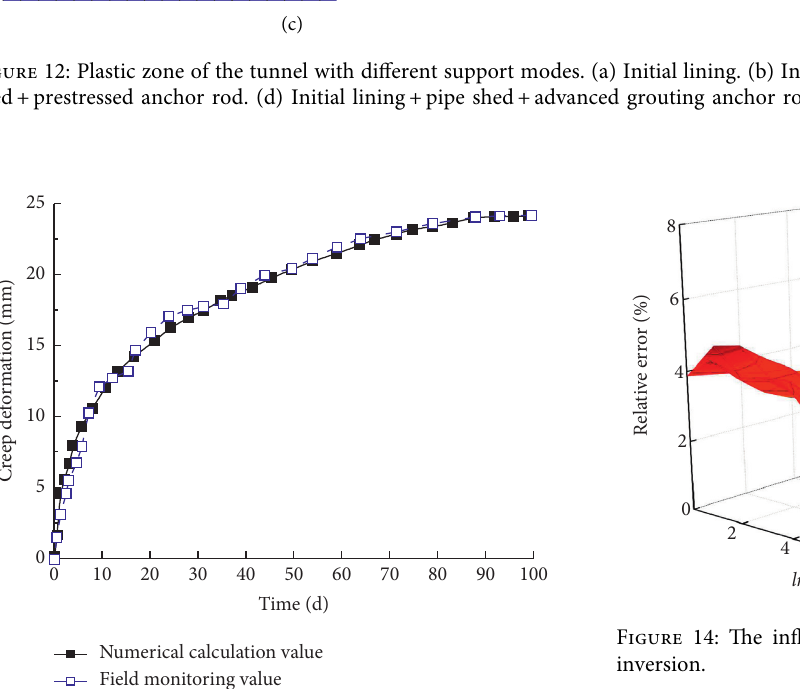
Figure 13: Creep deformation curve of the tunnel crown.